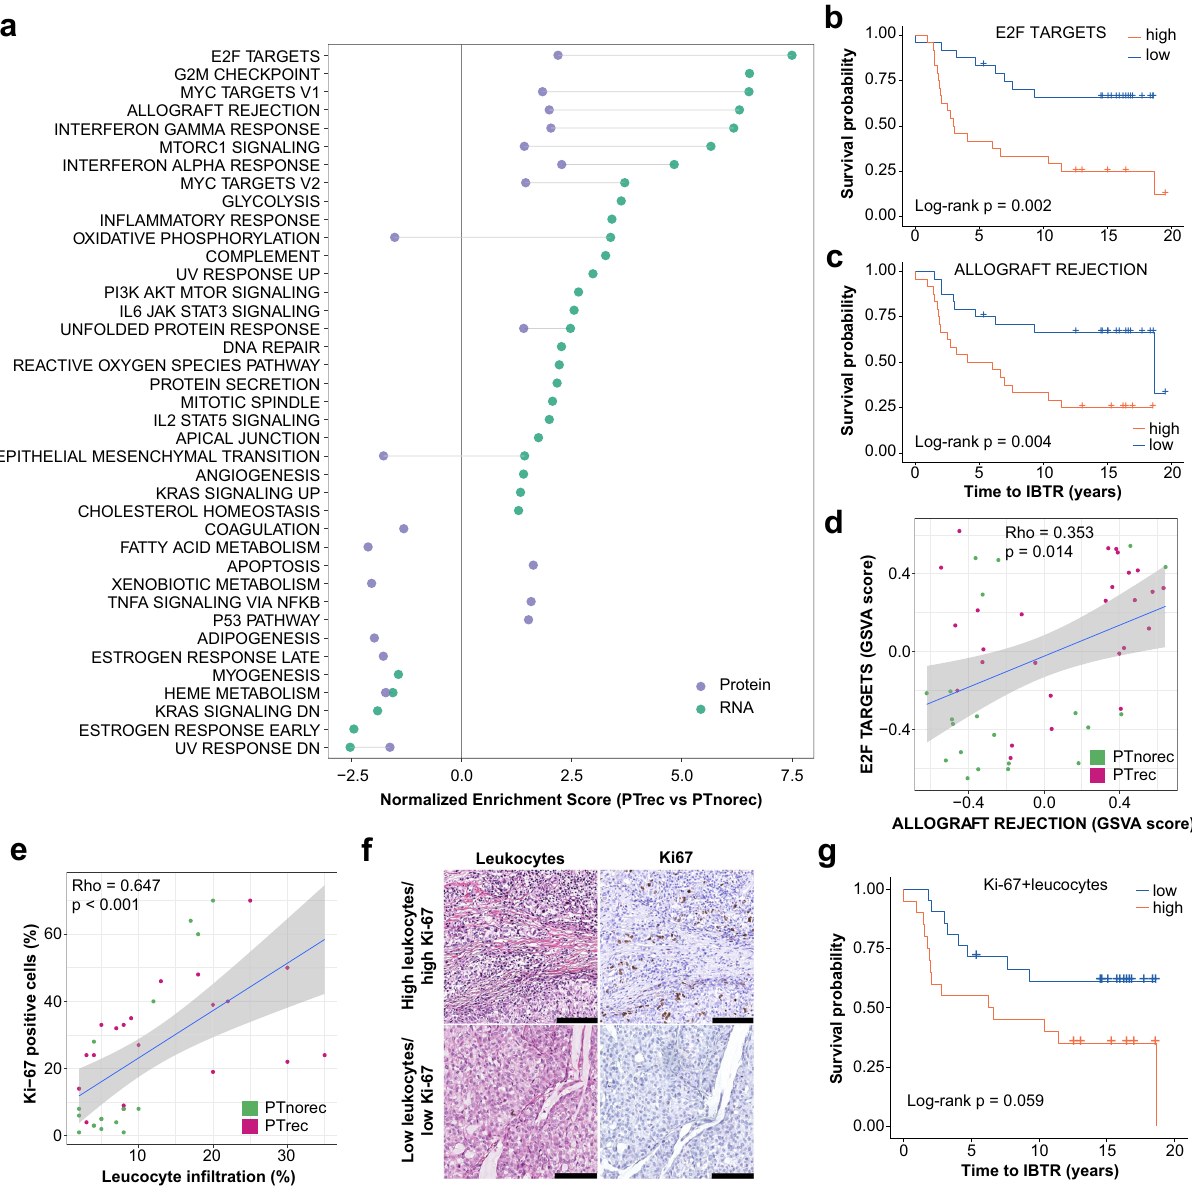
Fig. 6 Proliferation and immune in fi ltration promote IBTR formation. PTrec and PTnorec samples were compared to de fi ne possible determinants of IBTR formation. a GSEA analysis using HALLMARK database. b , c Survival curves of GSVA scores (cutoff: median) for top pathways pertaining to proliferation (E2F TARGETS) and immune signaling (ALLOGRAFT REJECTION). d Correlation analysis of GSVA scores for E2F TARGETS and ALLOGRAFT REJECTION. e correlation between Ki-67 and in fi ltrating leukocytes. f Examples of tissues with high and low levels of Ki-67 (evaluated by IHC) and in fi ltrating leukocytes (evaluated by hematoxylin-eosin staining). Black bars represent 100 µ m. Panel g represents survival analysis for the combined Ki-67 + leucocytes score (cutoff: median). Number of samples included in each test depends on availability of clinical data. In scatter plots linear regression is depicted in blue, while gray area represents the 95% con fi dence interval of the regression. GSEA gene set enrichment analysis, GSVA gene set variation analysis, Ki-67 antigen Ki-67, IBTR ipsilateral breast tumor recurrence, IHC immunohistochemistry, PT primary